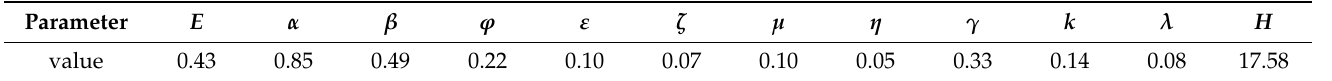
Table 1. Parameter values of photosynthetic potential yield calculation equation.